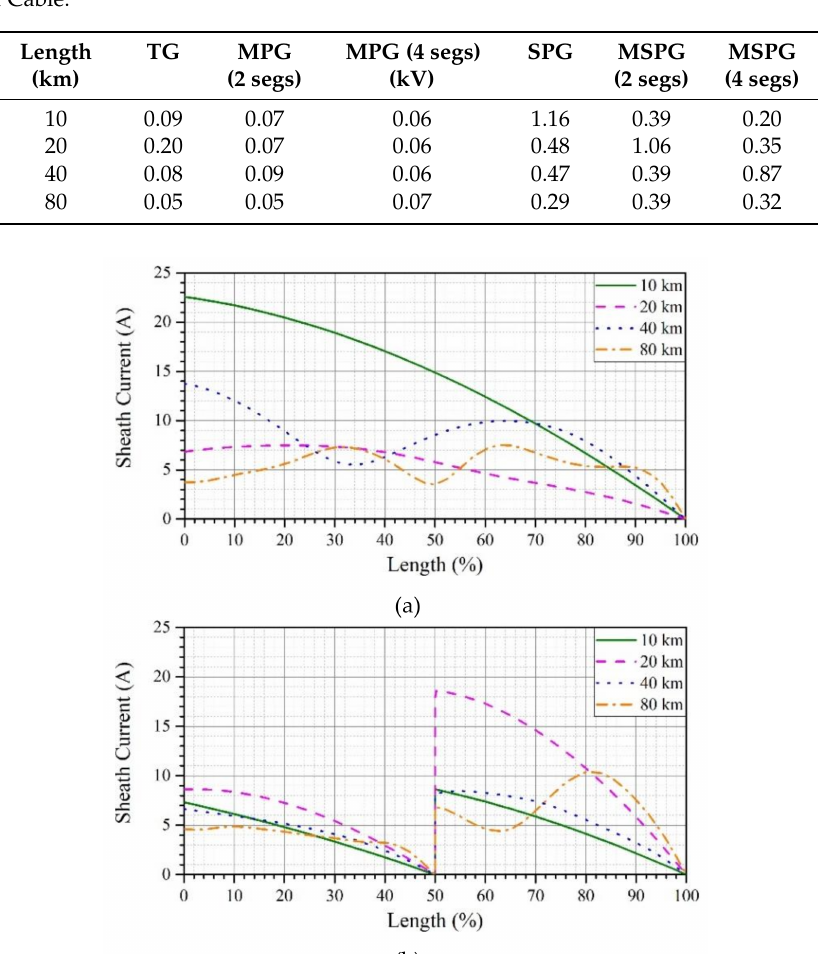
Figure 13. Steady state sheath voltage along length of 10, 20, 40 and 80 km cable ( a ) Single Point Grounded (SPG). ( b ) Multiple Single Point Grounded (MSPG—2 segments). ( c ) Multiple Single Point Grounded (MSPG—4 segments). Table 3. Maximum Steady State Sheath Voltage (in kV) According to Sheath Grounding Scheme and Length of Cable.